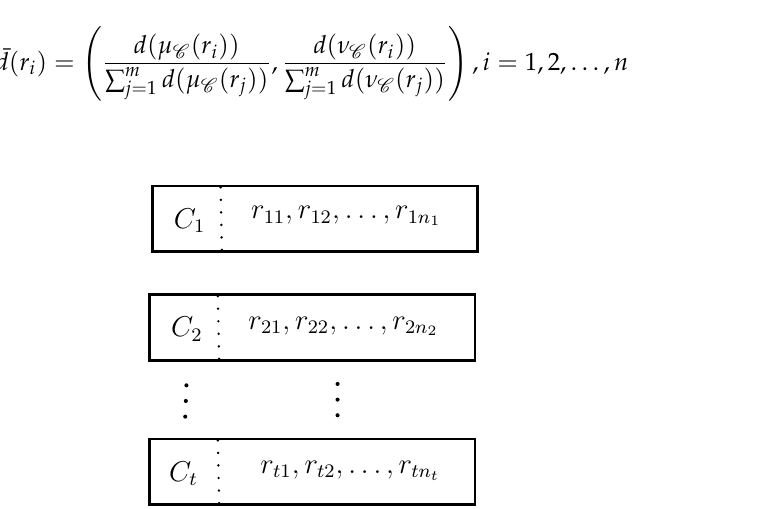
Figure 11: Prioritized hierarchies of attributes (criteria) set. Figure 11. Prioritized hierarchies of attributes (criteria)